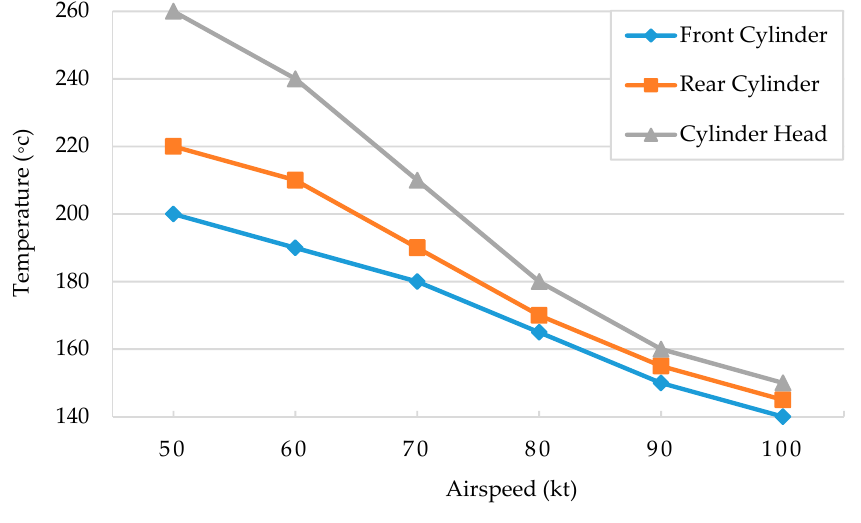
Figure 4. Graph relationships between temperature (°C) and airspeed (kt) at an initial temperature of 180 °C.